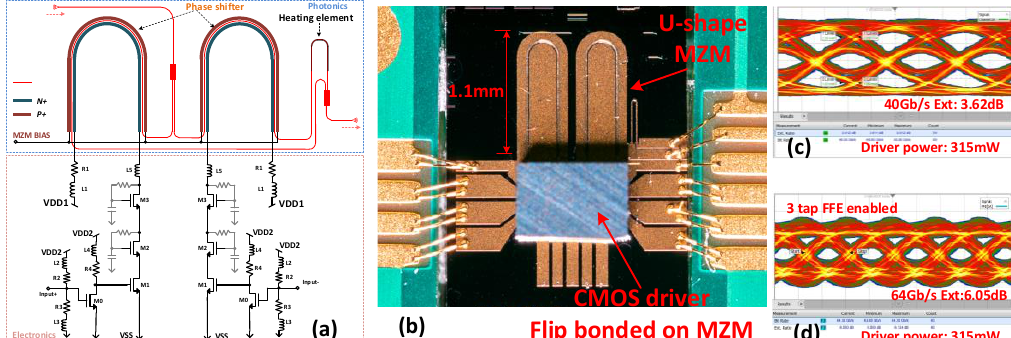
Figure 17. The integrated Si photonics transmitter. ( a ) Circuit diagram of the Si MZM integrated with the complementary metal oxide semiconductor (CMOS) driver, ( b ) microscope image of the integrated Si photonics transmitter, ( c ) measured optical results at 40 Gb / s and ( d ) measured optical results at 64 Gb / s with 3-tap feed forward equalization